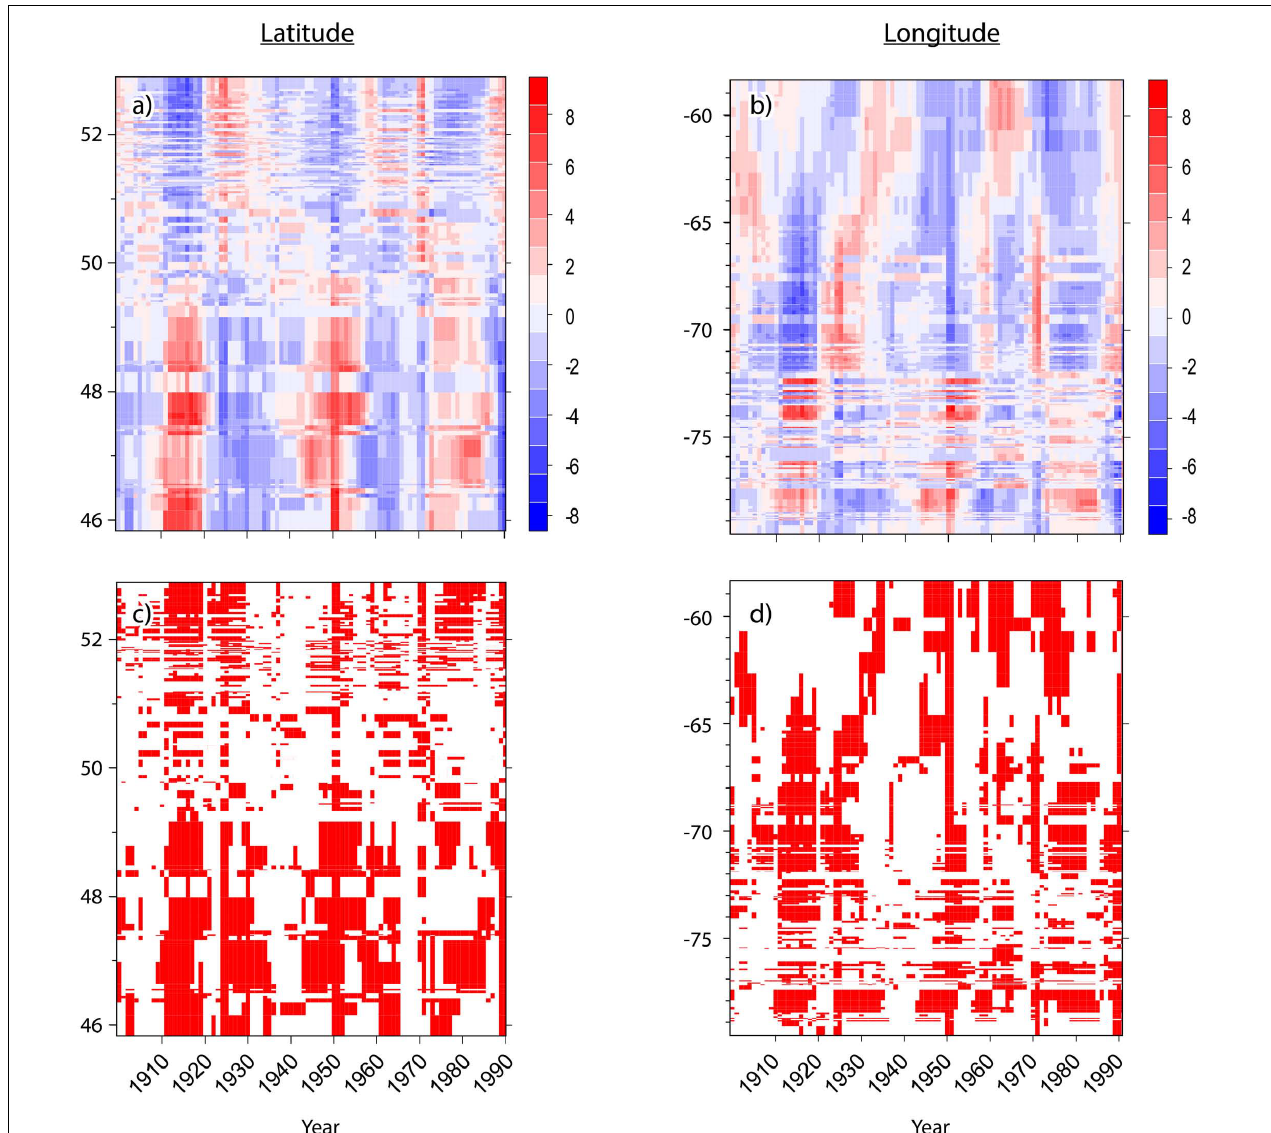
FIGURE 3 | Hovmöller diagrams for the spatiotemporal patterns of spruce budworm outbreak impacts during the last century in eastern Canadian boreal forests where (A,B) represent the Z-scores of Getis-Ord Hotspot analysis by latitude (left) and by longitude (right), respectively. Red represents hotspots having a high percentage of affected trees. Blue represents cold spots having a low percentage of affected trees. (C,D) present, the significance by latitude and longitude, respectively. Red, p -value < 0.05; White, p -value >